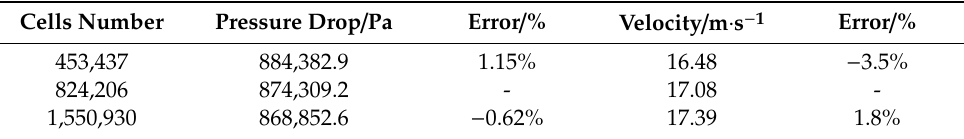
Figure 3. Mesh of the two-cage globe valve. Table 3. Grid independence check.